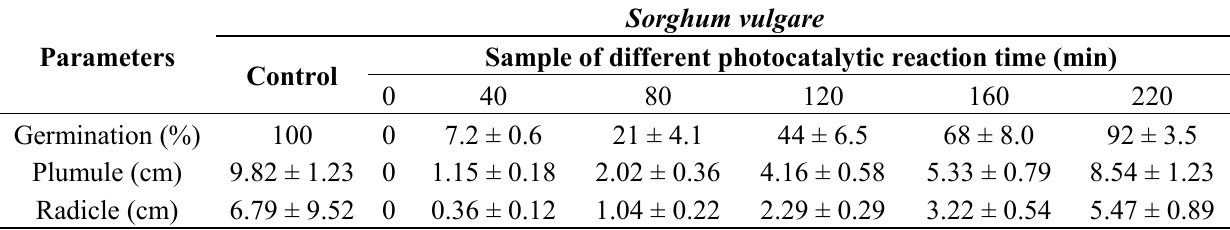
Table 4. The phytotoxicity study for Sorghum vulgare seeds by using treated IC wastewater. The results are the mean of triplicates (mean ± SD).